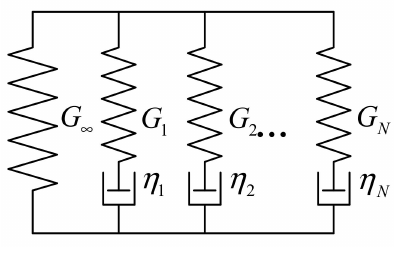
Figure 2. Generalized Maxwell